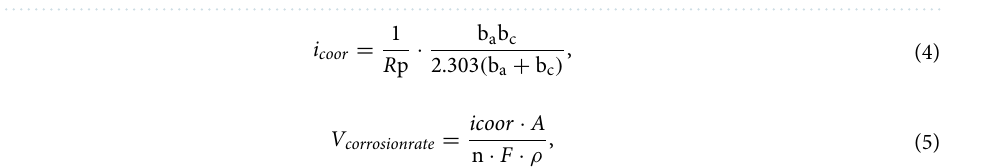
Table 3. The fitting data of polarization resistance in the BM